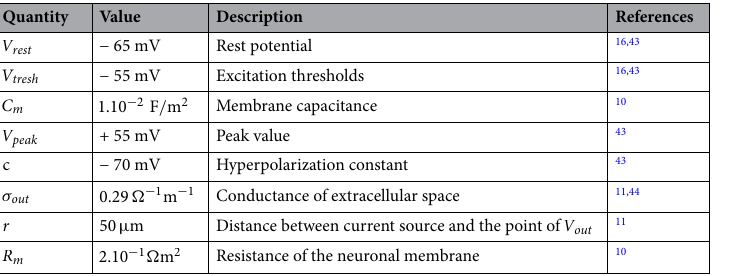
Table 1. Cell membrane biophysical parameters employed in the simulation of the quadratic integrate-and- fire model.